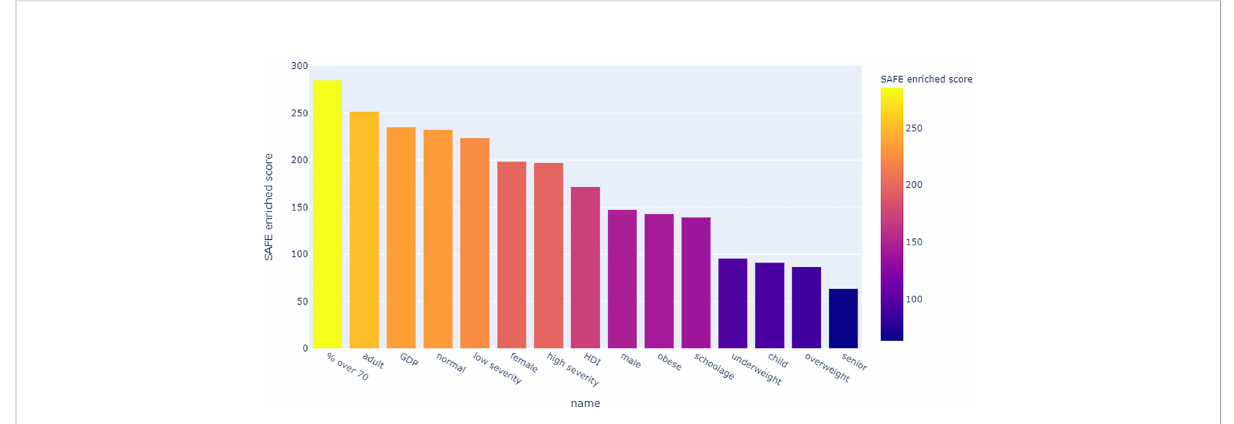
FIGURE 8 Shown is the association matrix of pairwise co-enrichment of all metadata and the 15 top taxa. The top taxa are a combination of the 10 taxa with the highest SAFE enriched scores (network-wide) and the 10 taxa with the highest number of enriched nodes. The colours represent the p- value, asterisks indicate signi fi cance at the 0.5th percentile of all pairwise associations (not all represented in the matrix). Of note, the low severity group is associated with the taxa Eubacterium rectale, Bi fi dobacterium longum and Bi fi dobacterium bi fi dum , and the population-level confounders GDP, HDI, and the proportion of over 70s in the population. These bacteria are also associated with each other, the same holds true for the confounders. Additionally, the bacteria and confounders are associated with each other and other anti-in fl ammatory bacteria such as Bi fi dobacterium adolescentis or Faecalibacterium prausnitzii